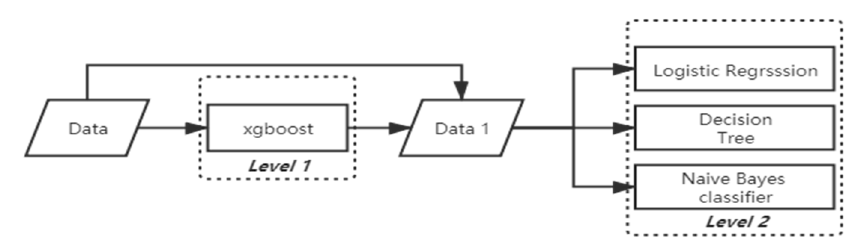
Figure 4. The proposed stacking model.